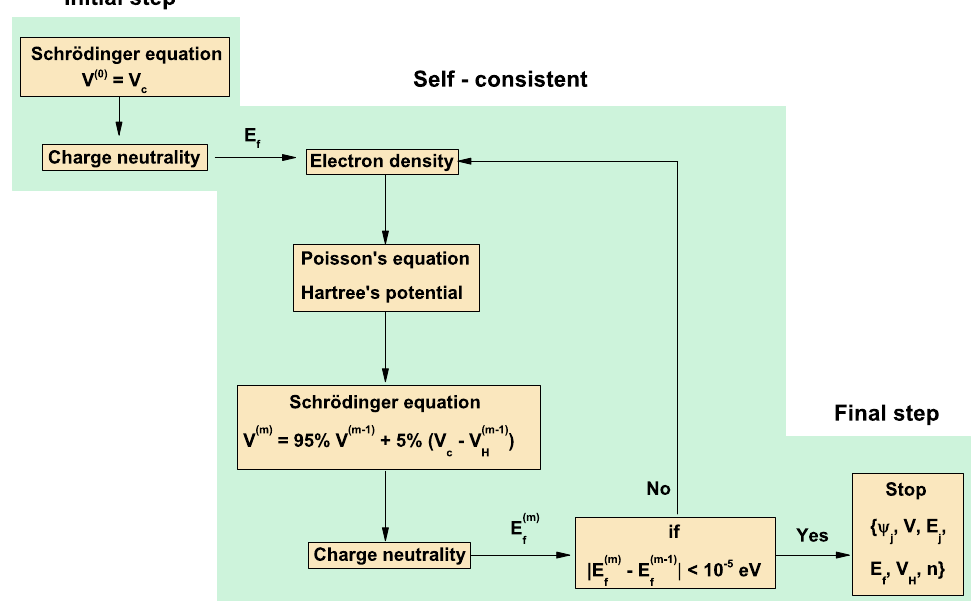
Figure 2. Block diagram corresponding to the self-consistent